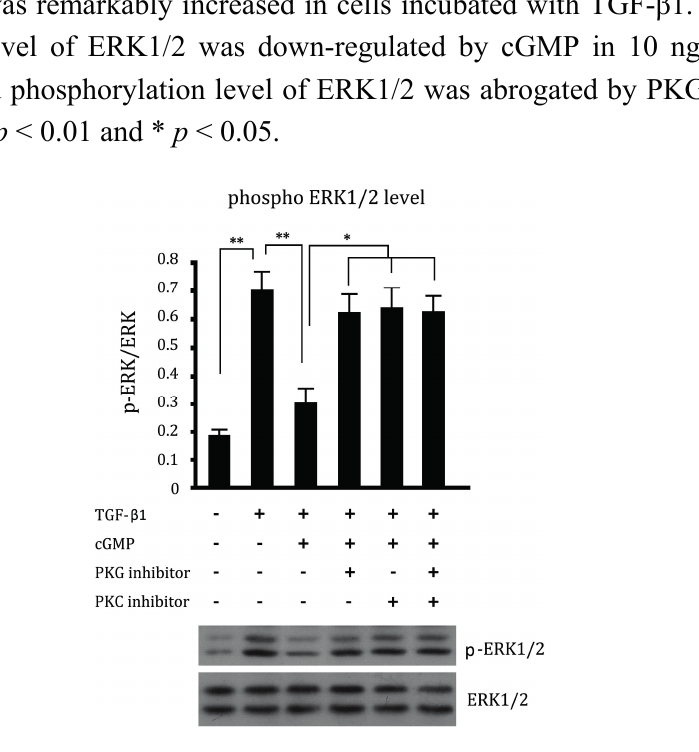
Figure 6. The different subtypes of PKC were studied. The groups were marked as following: 1, Cell; 2, TGF- β 1 (10 ng/mL); 3, TGF- β 1 (10 ng/mL) + Cgmp (100 ng/mL); 4, TGF- β 1 (10 ng/mL) + Cgmp (100 ng/mL) + PKC inhibitor; 5, TGF- β 1 (10 ng/mL) + Cgmp (100 ng/mL) + PKC Δ siRNA; 6, TGF- β 1 (10 ng/mL) + cGMP (100 ng/mL) + PKC ζ siRNA; 7, TGF- β 1 (10 ng/mL) + cGMP (100 ng/mL) + PKC γ siRNA; 8, TGF- β 1 (10 ng/mL) + cGMP (100 ng/mL) + PKC β siRNA; 9, TGF- β 1 (10 ng/mL) + cGMP (100 ng/mL) + PKC α siRNA. ** p < 0.01 and * p <